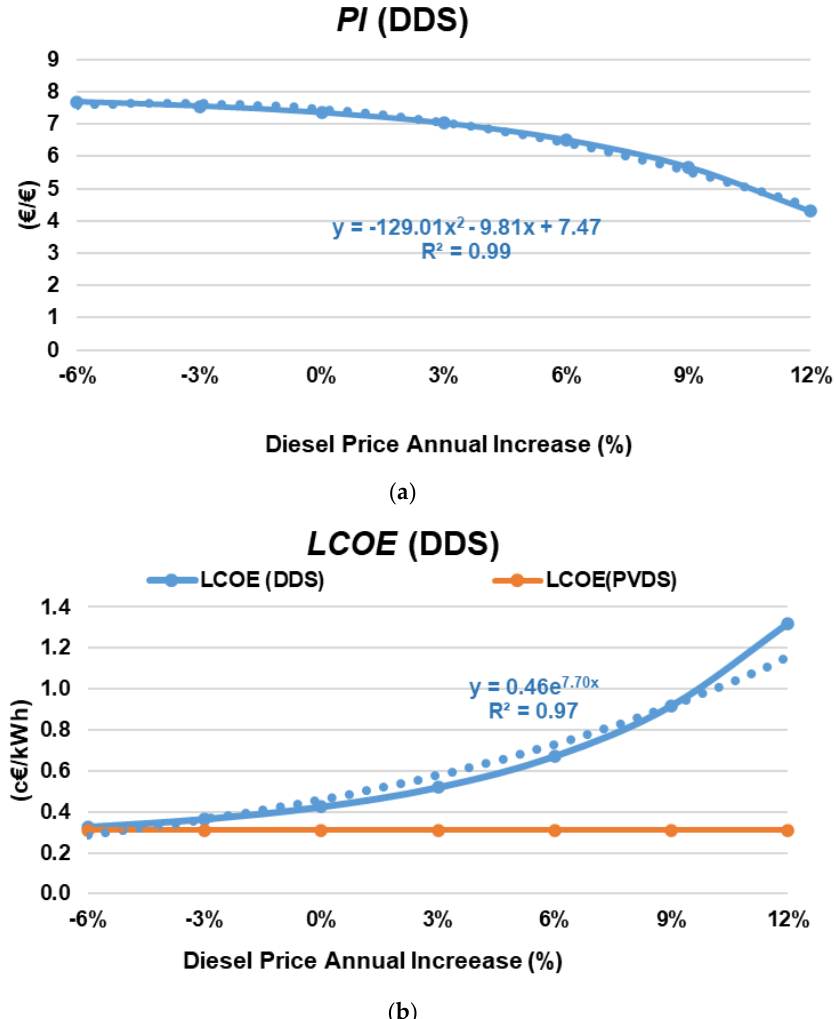
Figure 3. Profitability index ( a ), levelized cost of energy ( b ), and LCOE savings compared to the grid-powered drying system ( c ) obtained for an annual variation in electricity prices between −6% and